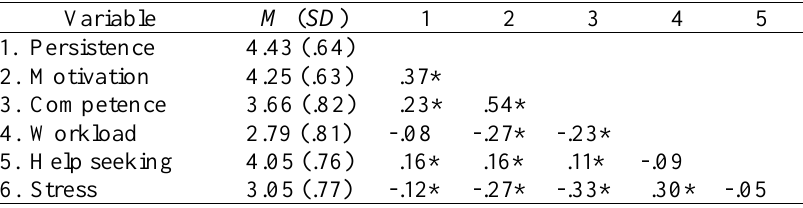
Means, Standard Deviations, and